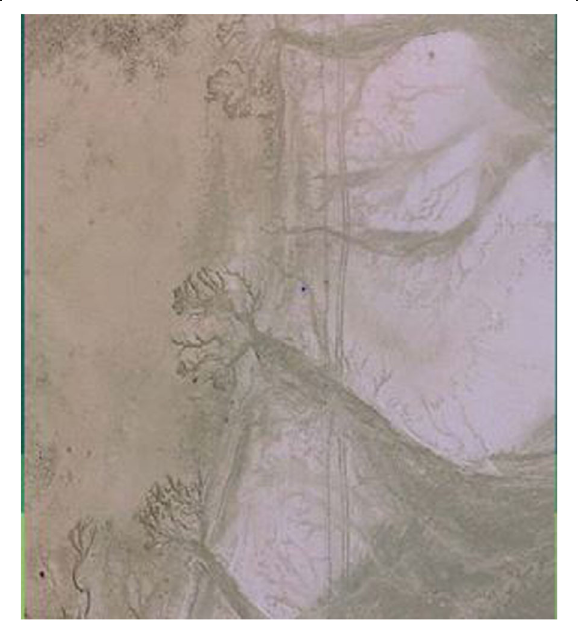
Fig. 4 Aerial photograph of area on the west of Lordsburg Playa showing erosional head cutting in the left portions of the picture and subsequent deposition of eroded sediment on the playa surface in the right-hand portions of the